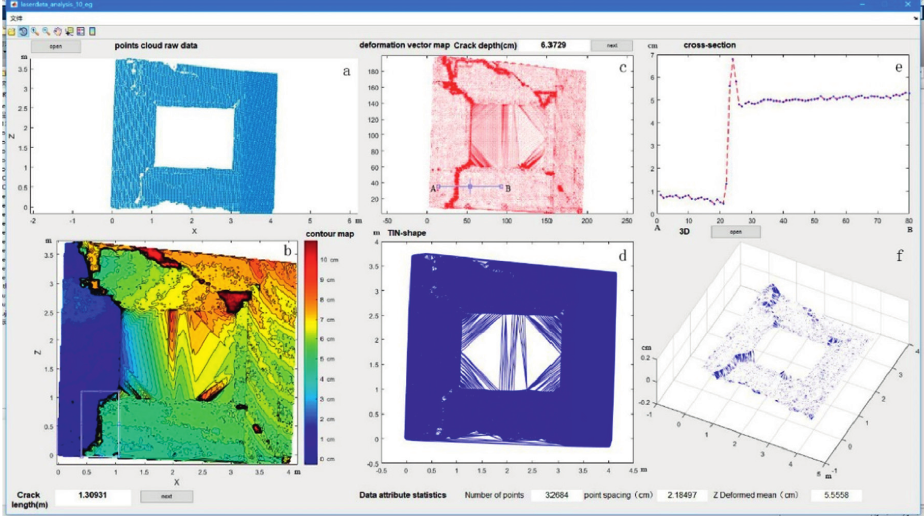
Figure 10: Building damage information extraction for brick and concrete structures.